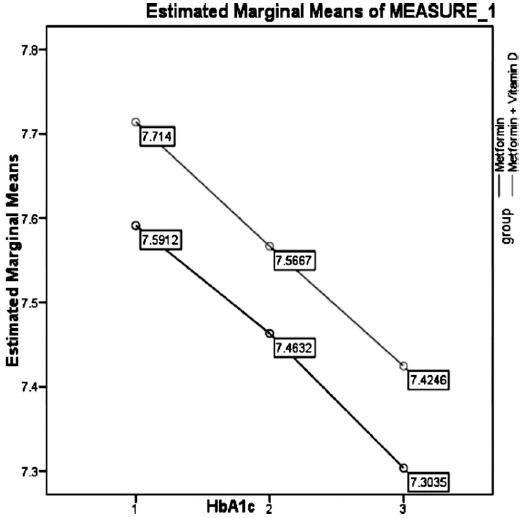
Comparison of HbA1c in both groups at different follow-ups. Repeated measurements ANOVA was applied p-value = 0.000 (Significant)